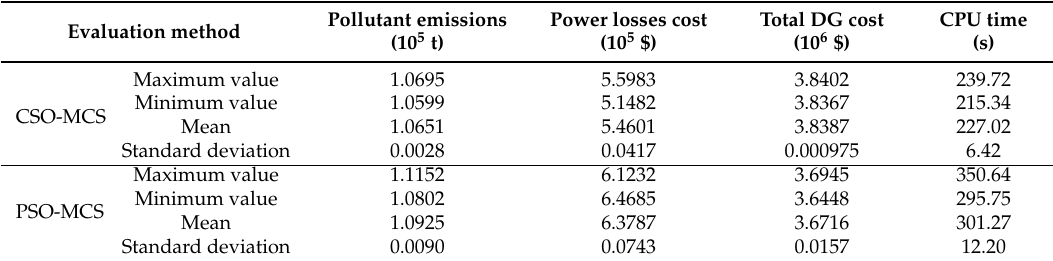
Table 4. Results obtained by crisscross optimization algorithm and Monte Carlo simulation (CSO-MCS) and particle swarm optimization and Monte Carlo simulation (PSO-MCS) (30 runs for Case 1).